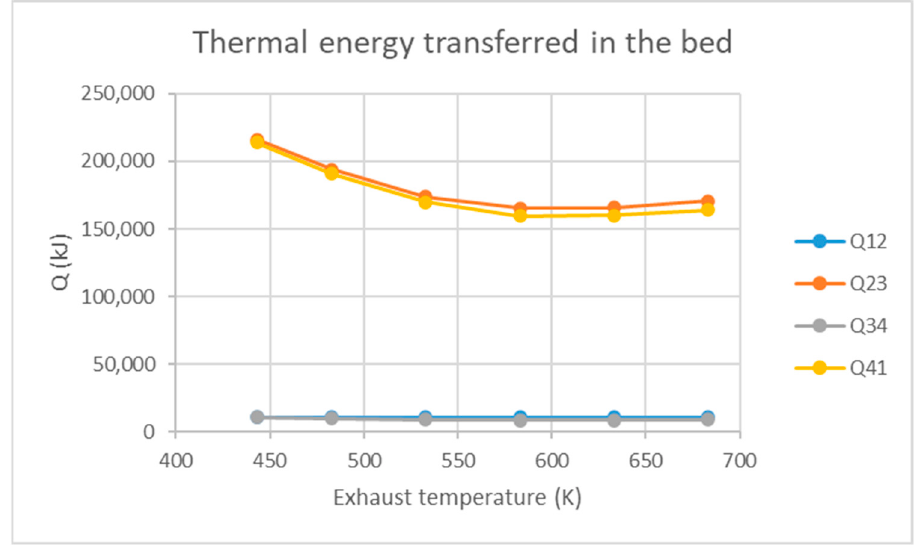
Figure 6. Transmitted thermal energy vs. exhaust temperature.